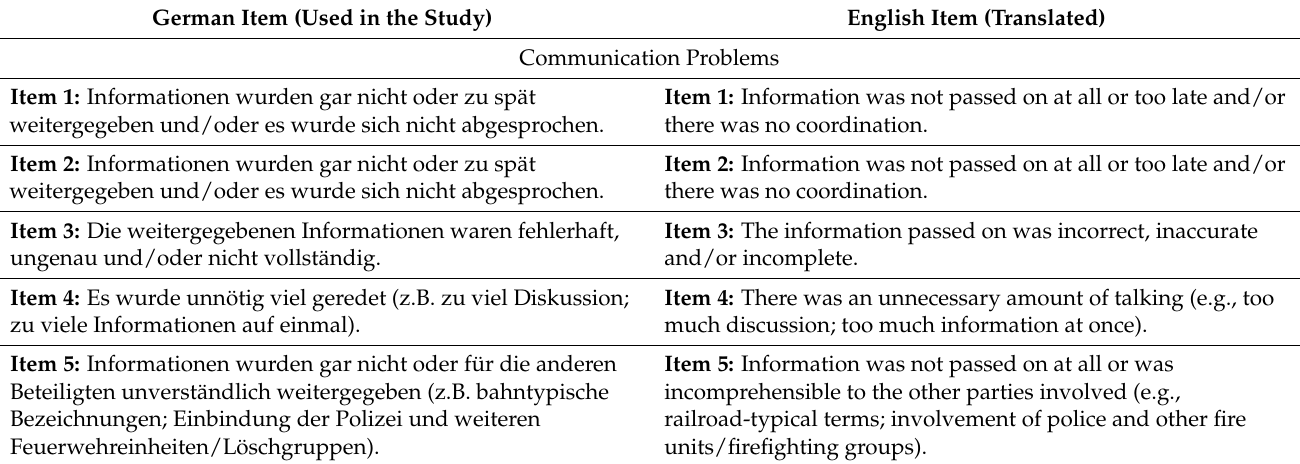
Table A1. Items of the Demands and Resources During Firefighting Missions